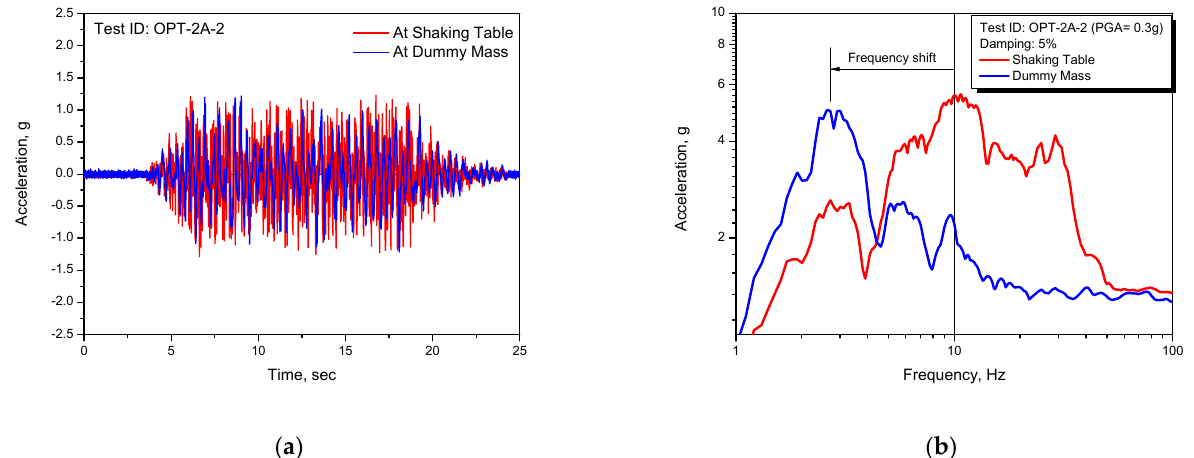
Figure 5. Test results for safe shutdown earthquake (PGA = 0.3 g): ( a ) Acceleration time histories; ( b ) Corresponding response